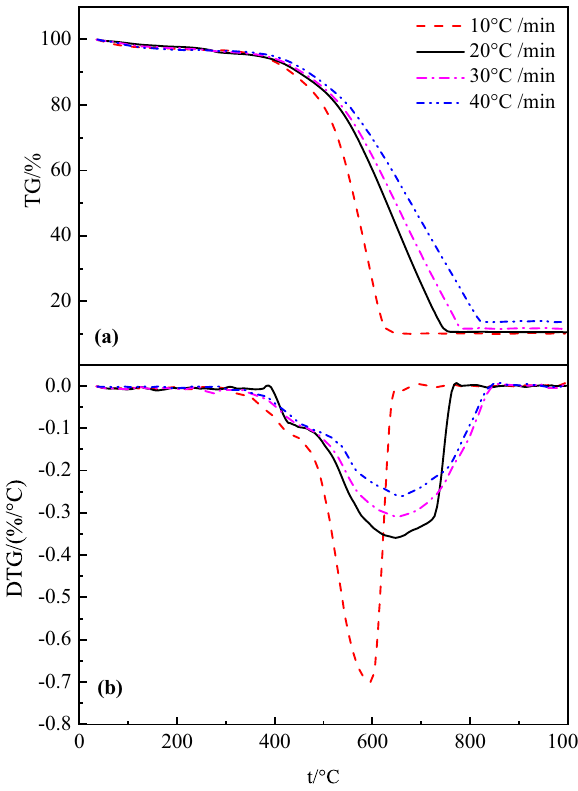
Figure 2: TG – DTG curves of D2 sample at di ff erent heating rates: ( a ) TG and ( b ) DTG